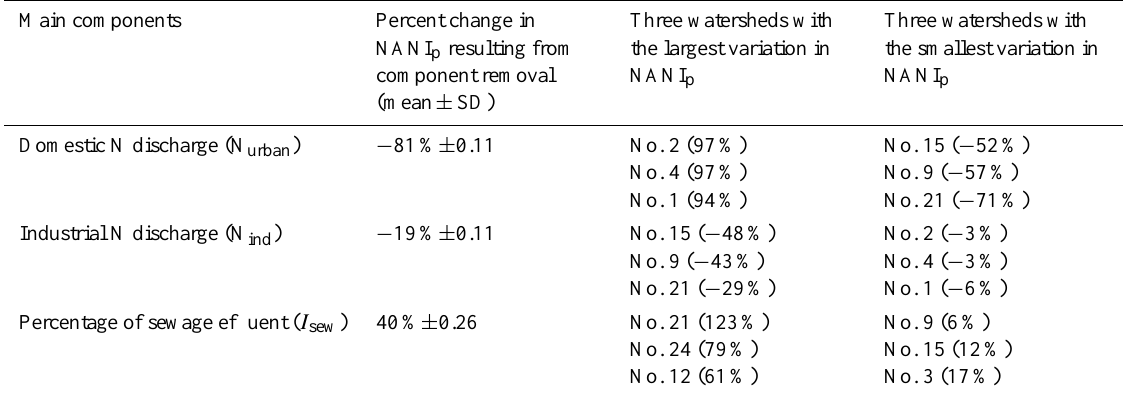
Table 4. Percent change in point N input (NANI p ) resulting from component removal. Main